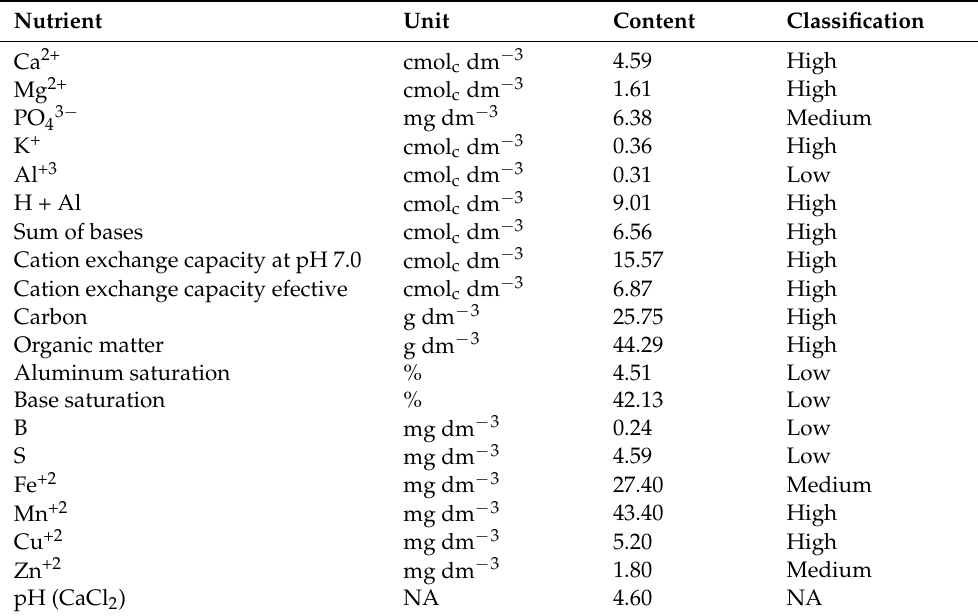
Table 1. Main chemical characteristics of the soil in the experimental area before fertilization. Contents were classified as low, medium, or high based on the ranges specified in the Paran á State Handbook for Fertilization and Liming